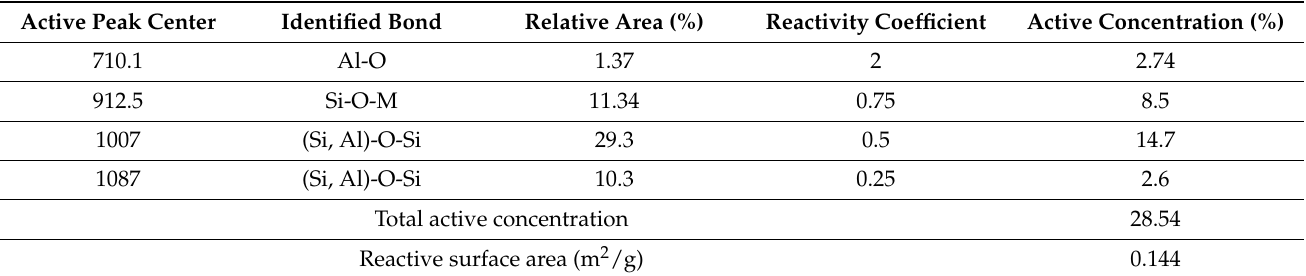
Figure 3. FTIR absorbance and Gaussian curves of active bonds in the FA sample. Table 3. Reactive bond parameters and reactivity calculation of the FA sample.